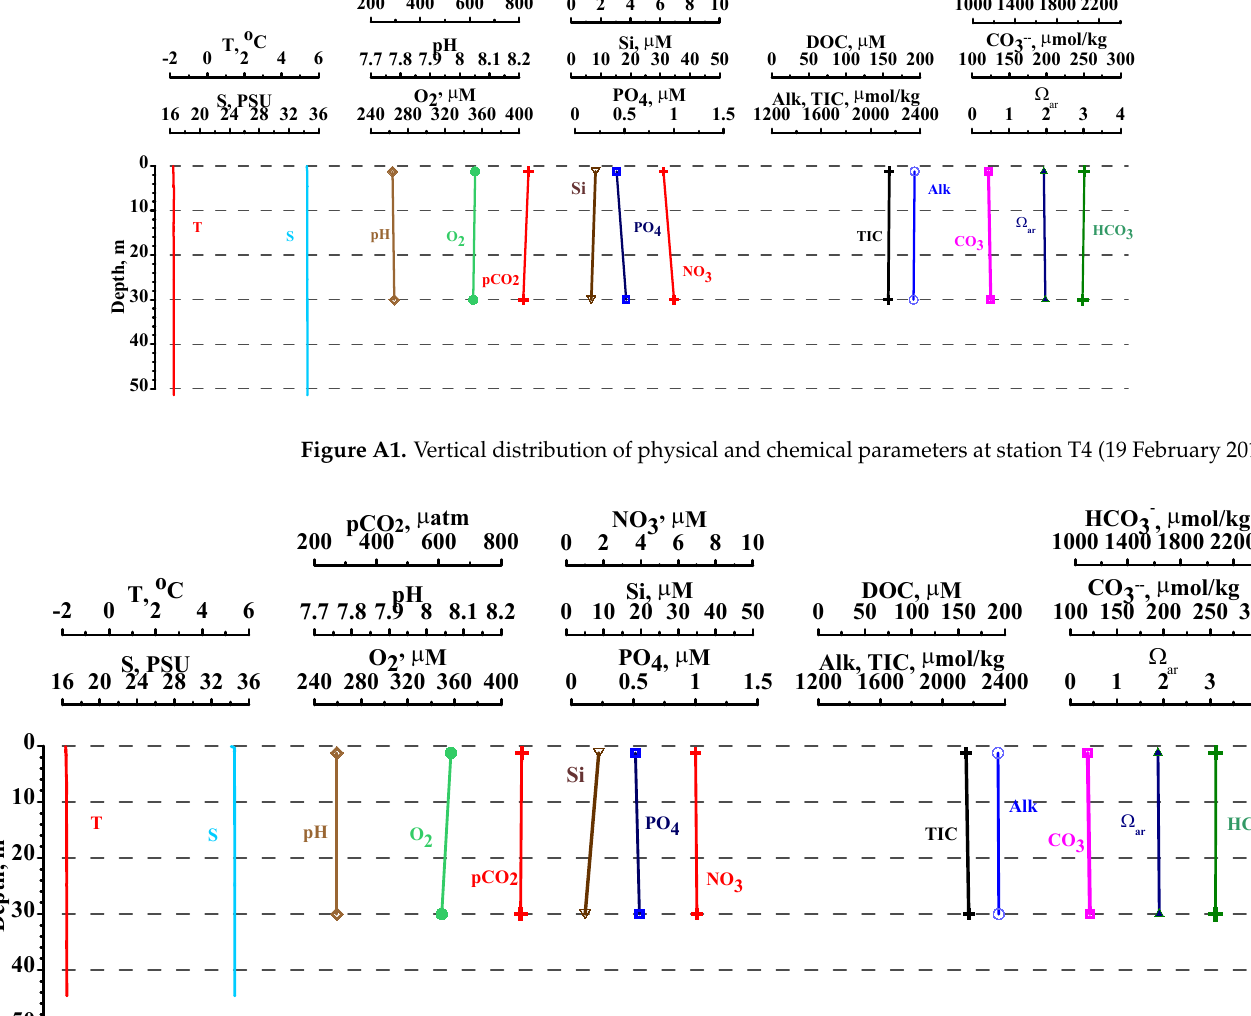
Figure A2. Vertical distribution of physical and chemical parameters at station T5 (19 February 2011).